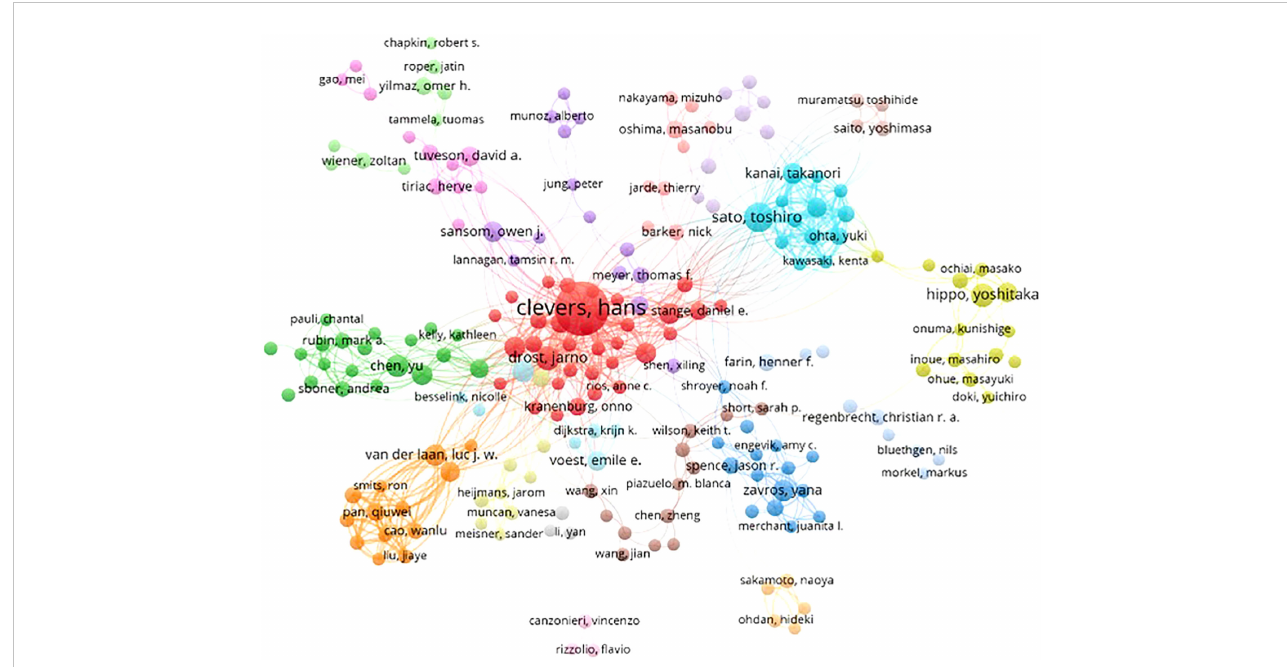
FIGURE 6 Collaborative networks among authors with a high publication volume of tumor organoid research.